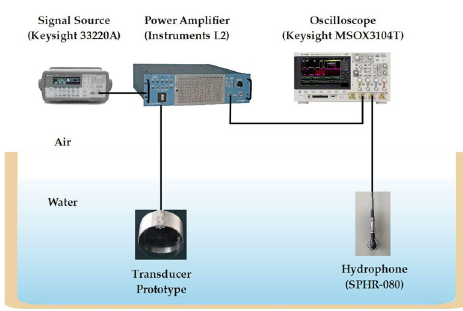
Figure 9. Framework of the test system.